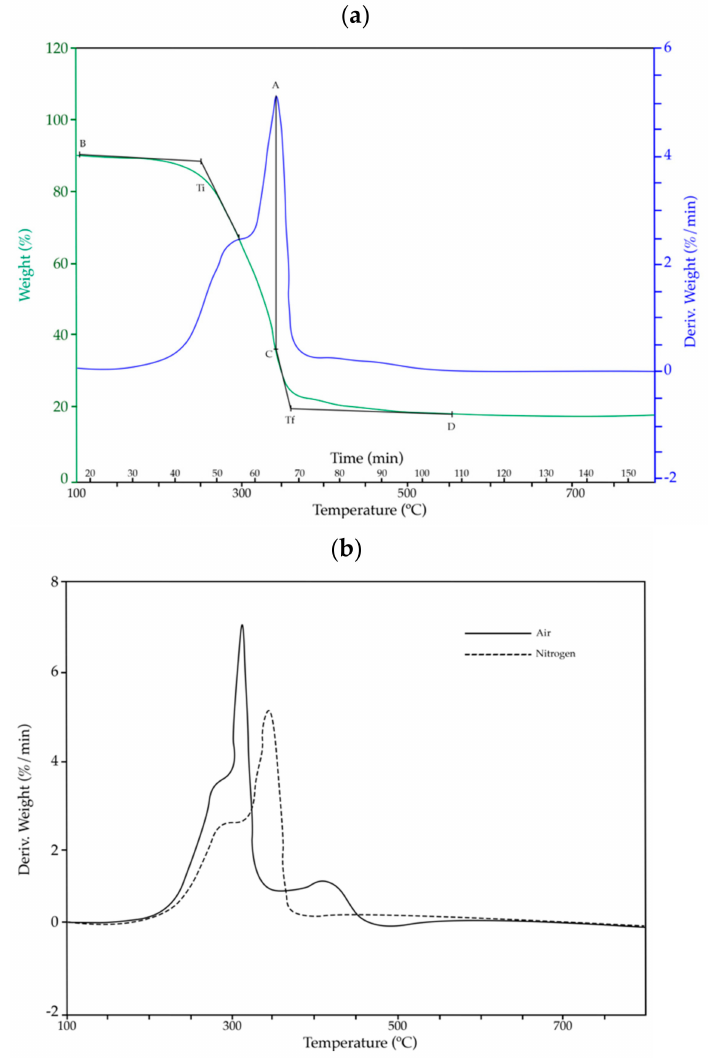
Figure 1. Ignition and burnout temperatures. ( a ) Intersection method and ( b ) Deviation